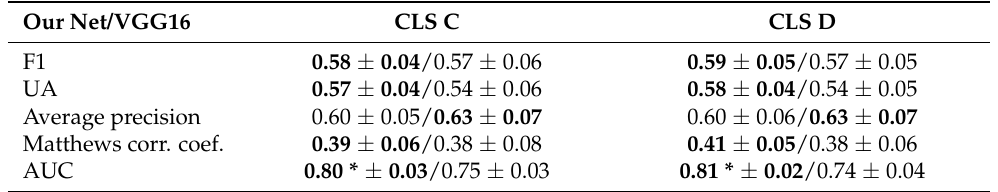
Table 2. Classification performance of our proposal and VGG16 for the categorical model prediction task. Two ways of predicting the emotion categories were tested. Comparisons where a network significantly outperforms the other (i.e., p -value < 0.05) are marked with the symbol *. The best result for each comparison is highlighted in bold.